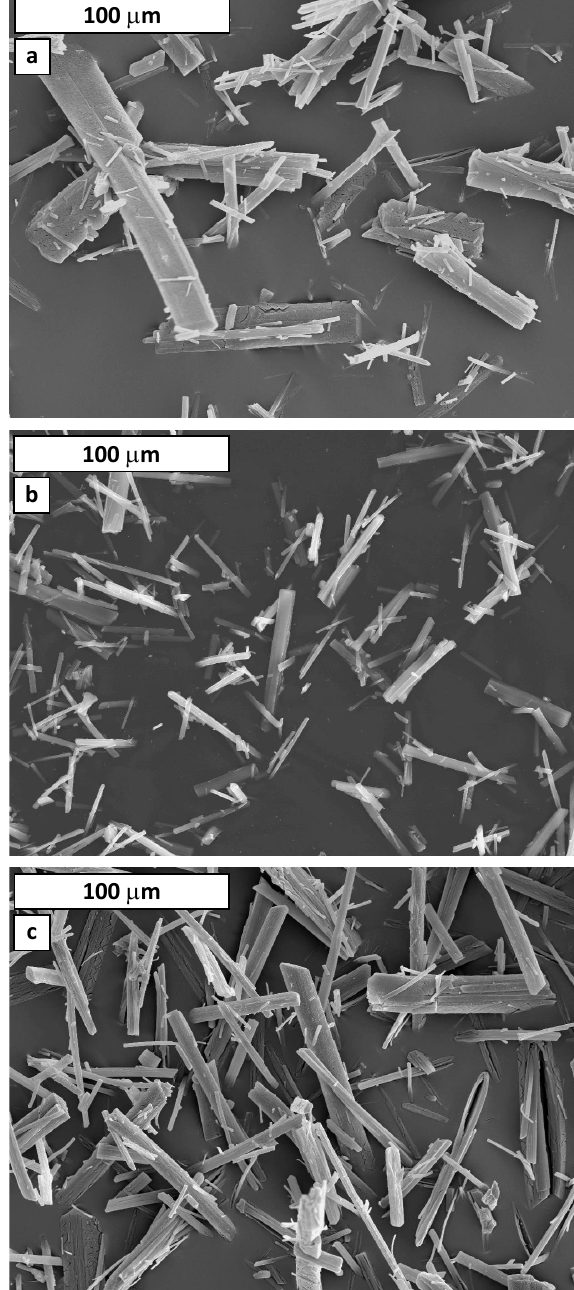
Figure 3: Scanning electron microscope images of struvite crystals produced in continuous reaction crystallization process (1.0 mass% of PO 43– , 0.10 mass% of SO 42– ) in DT MSMPR crystallizer. Process parameters: a) pH 9, τ 900 s, b) pH 11, τ 900 s, c) pH 9, τ 3600 s (corresponding Crystal Size Distributions, Fig. residence time of suspension up to 3600 s caused the dominant size L of struvite crystals to shift towards larger d values: from 23.8 µm (τ 900 s) up to 50.2 µm (τ 3600 s). The largest crystals reached 130 µm (τ 900 s, Fig. 2a) and 250 µm (τ 3600 s, Fig. 2c). The fraction of the smallest